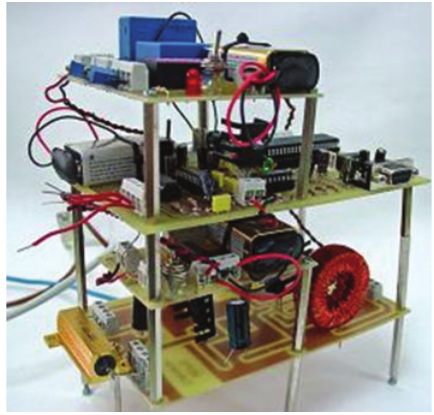
Figure 5: PCBs of the